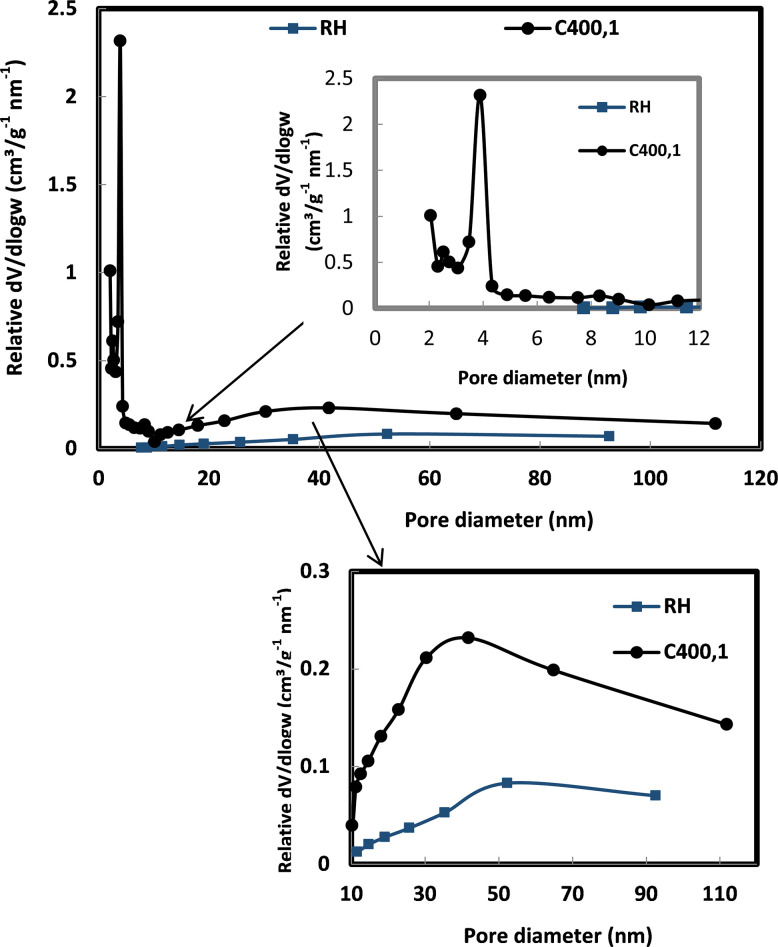
Pore size distribution of RH, and C400,1.